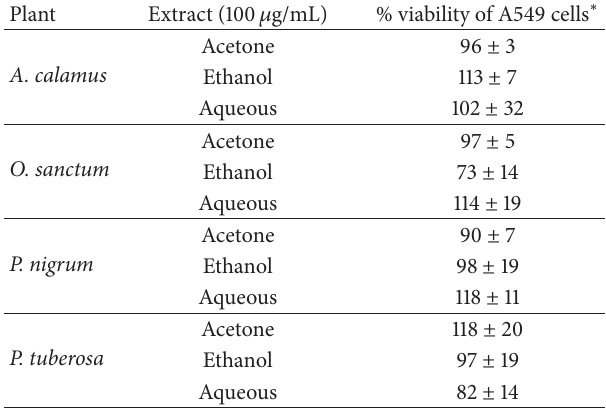
Table 2: Cytotoxicity of the four plants used in intracellular assay using A549 cells.